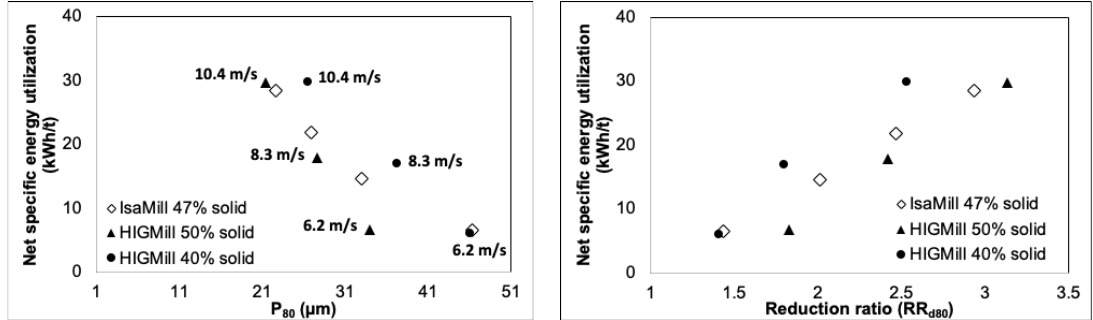
Figure 11. Signature plots of IsaMill and